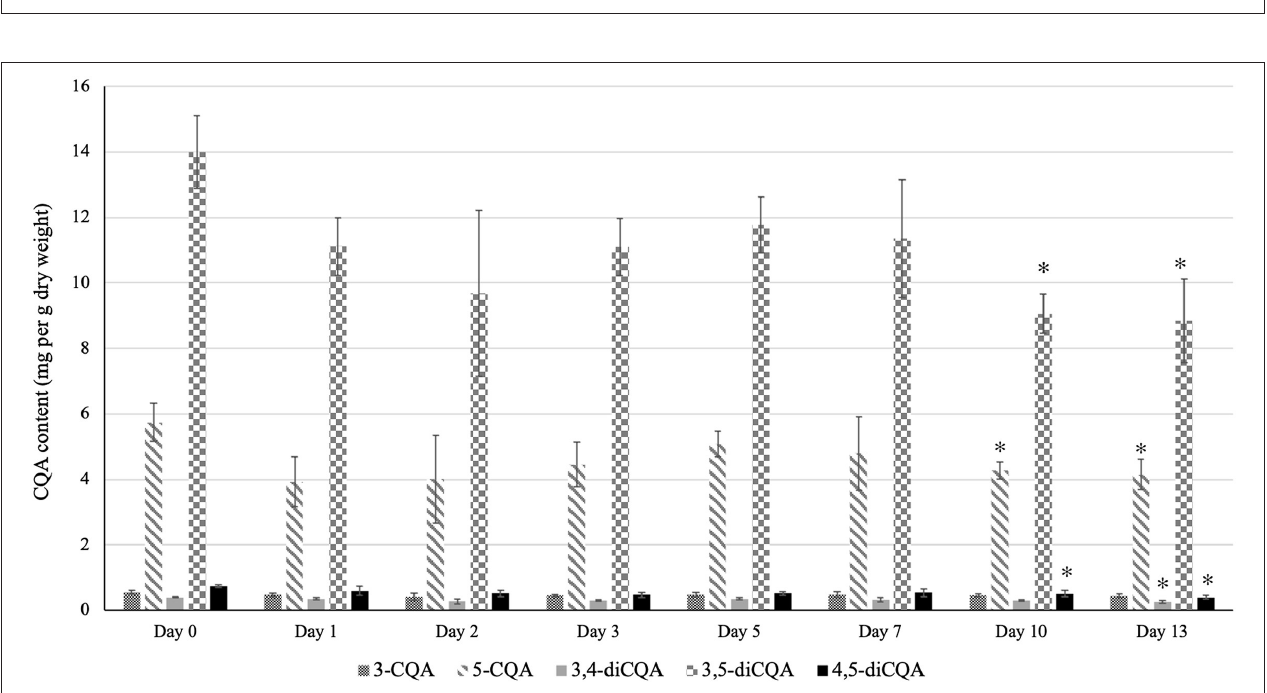
FIGURE 3 | Effect of low-temperature storage on the CQA content of sunflower sprouts. The CQA profile of sunflower sprouts were analyzed after storage under simulated home-refrigeration storage conditions for 13 days. Error bars represent means ± standard deviations (SD), and three independent biological replicates were performed. For each CQA derivative, an asterisk (*) above the bars indicates a significant difference compared to the sample at day 0 (control) (Student’s t -test, P < 0.05). The content of 3-CQA did not vary significantly during storage compared to the control sample (Student’s t -test, P > 0.05).